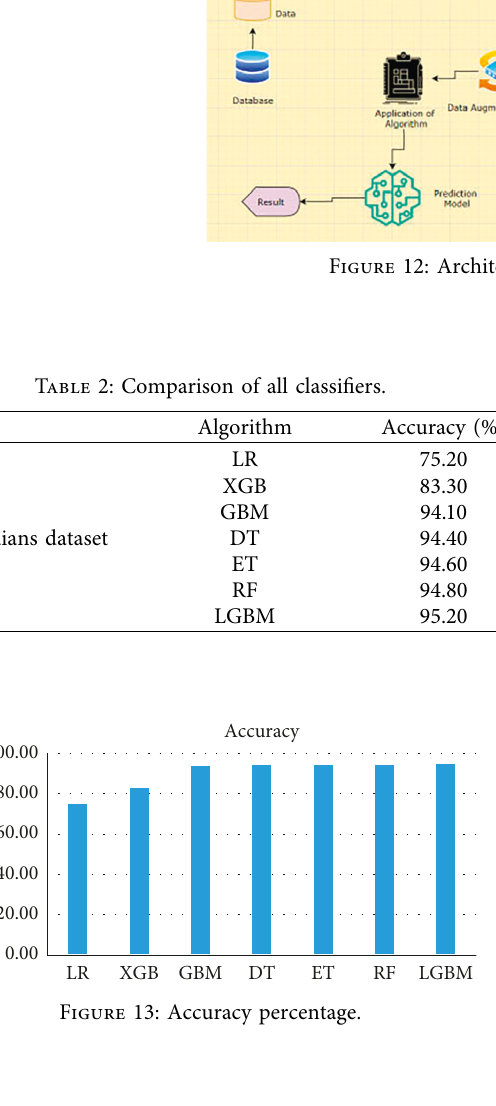
Table 3: Comparison of 3 classifiers.